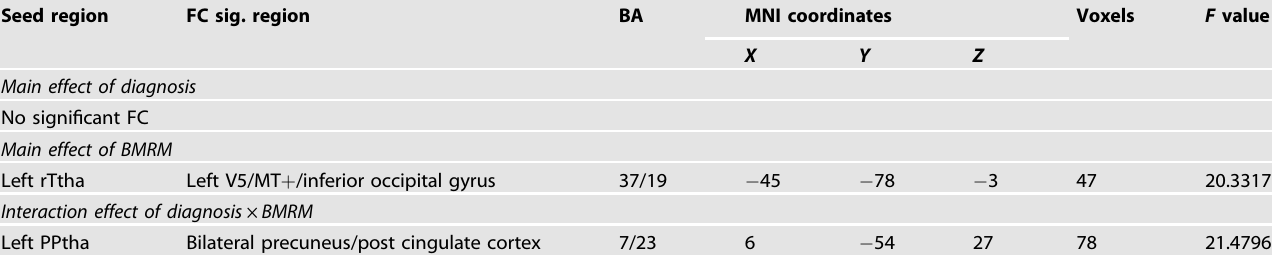
Table 3. Functional connectivity showing signi fi cant differences in 2 groups (MDD/HC) × 2 conditions (before BMRM/after BMRM) repeated measure ANOVA.